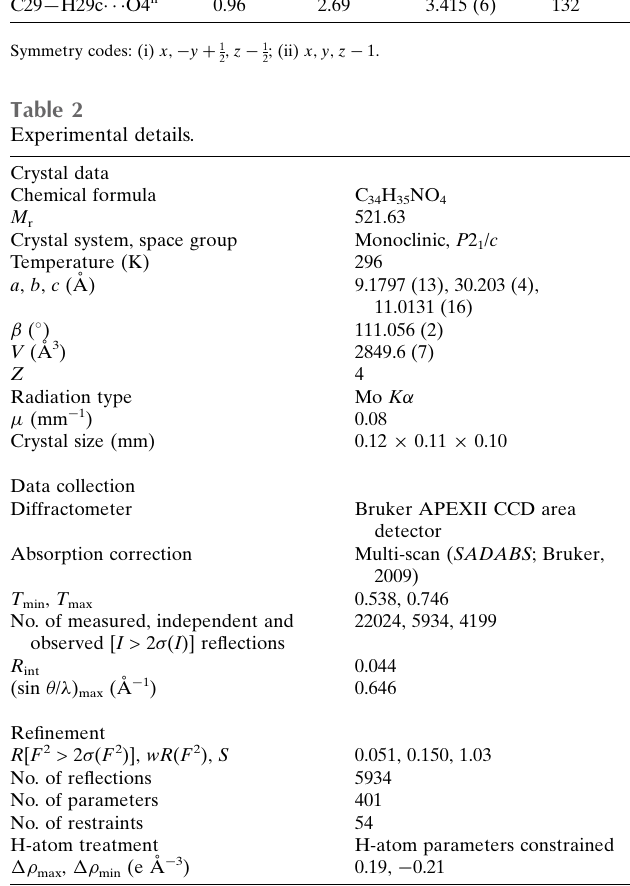
Figure 2 Weak C—H (cid:3)(cid:3)(cid:3) N and C—H (cid:3)(cid:3)(cid:3) O interactions in the title compound (blue and red lines, respectively). Symmetry codes: ( a ) x , 1